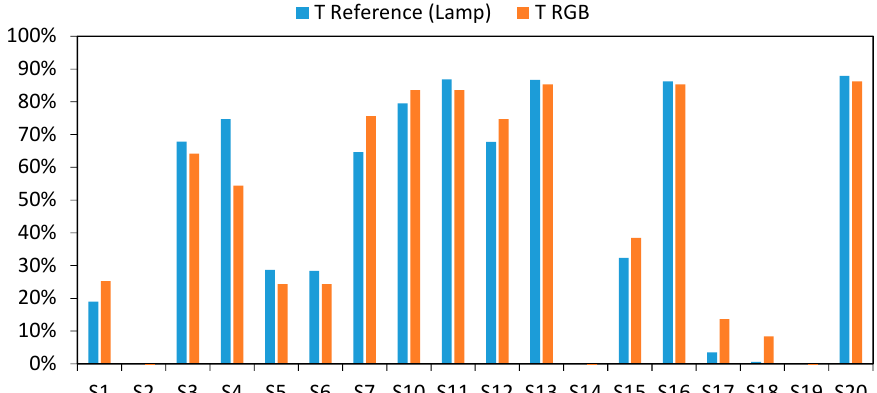
Figure 16. Comparative transmittance value by the RGB-LED and incandescent lamp at 580 nm.